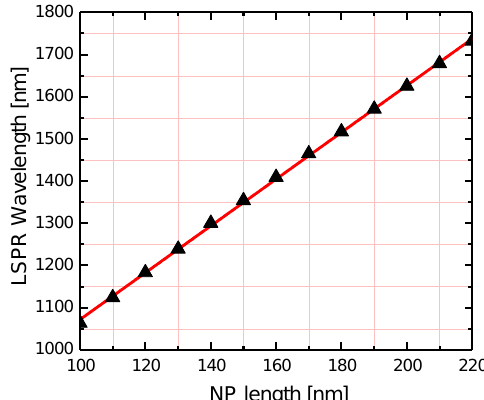
Figure A1. The LSPR spectral position as a function of NPs length L . The metasurface parameters were set to the following values: w = h = 20 nm, t = 100 nm, Λ 1 = 400 nm, and Λ 2 = 200 nm. Figure A2 clarifies the origin of the negative values obtained for the differential transmission. Transmission of the NMA covered metasurface is larger than that of immersion oil covered metasurface. Transmission spectra in (a) and (b) were computed for the NPs lengths optimized for sensing of the corresponding overtone